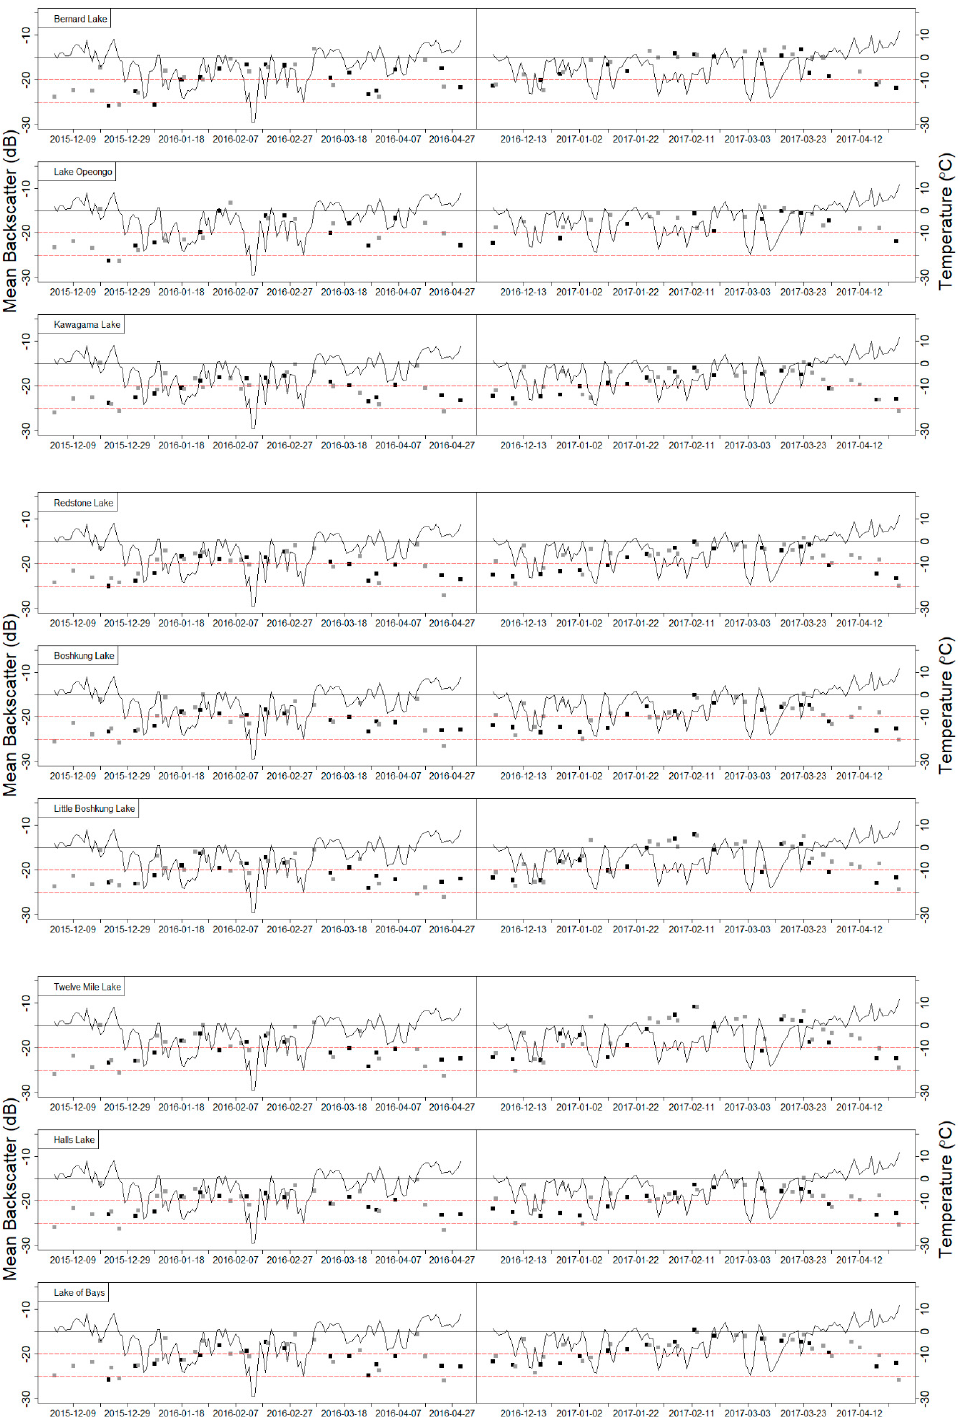
Figure A1. Mean backscatter evolution for nine of the major study lakes in Central Ontario. Black squares represent images that were acquired in the PM and grey squares represent images acquired in the AM. The black line represents daily mean temperatures and the solid line is 0 ◦ C. The dotted red lines represent a range of backscatter between − 20 and − 25 dB. Data for other ice seasons was obtained but is not